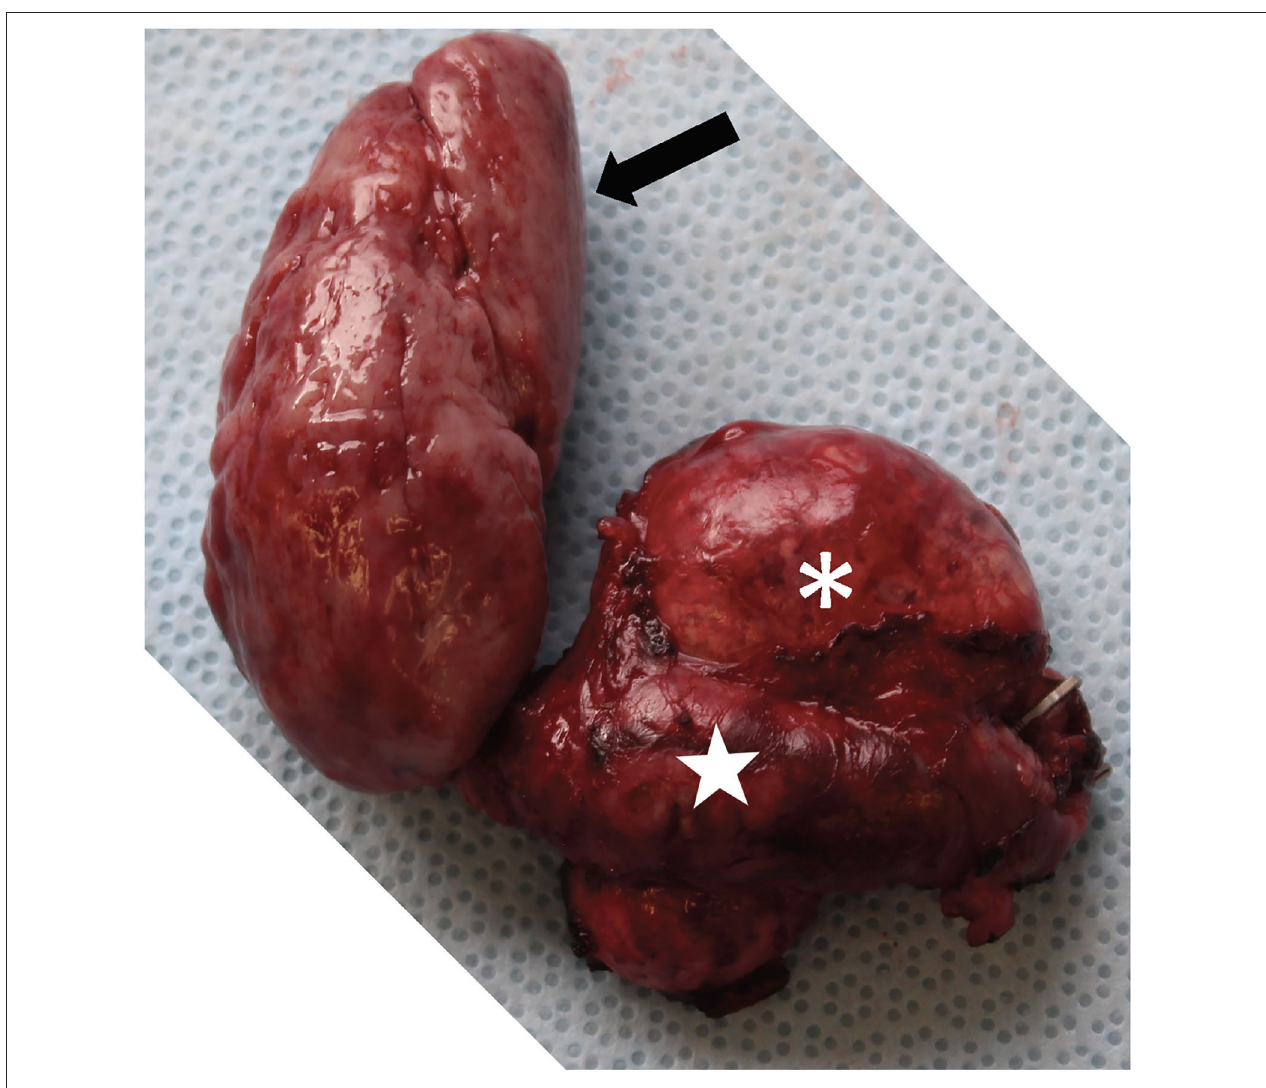
FIGURE 3 | Picture showing the pheochromocytoma after complete removal. Note the left adrenal mass (white asterisk), the severely distended left phrenicoabdominal vein (white star) and the tumour thrombus that extended into the CdVC for 10cm (black arrow).